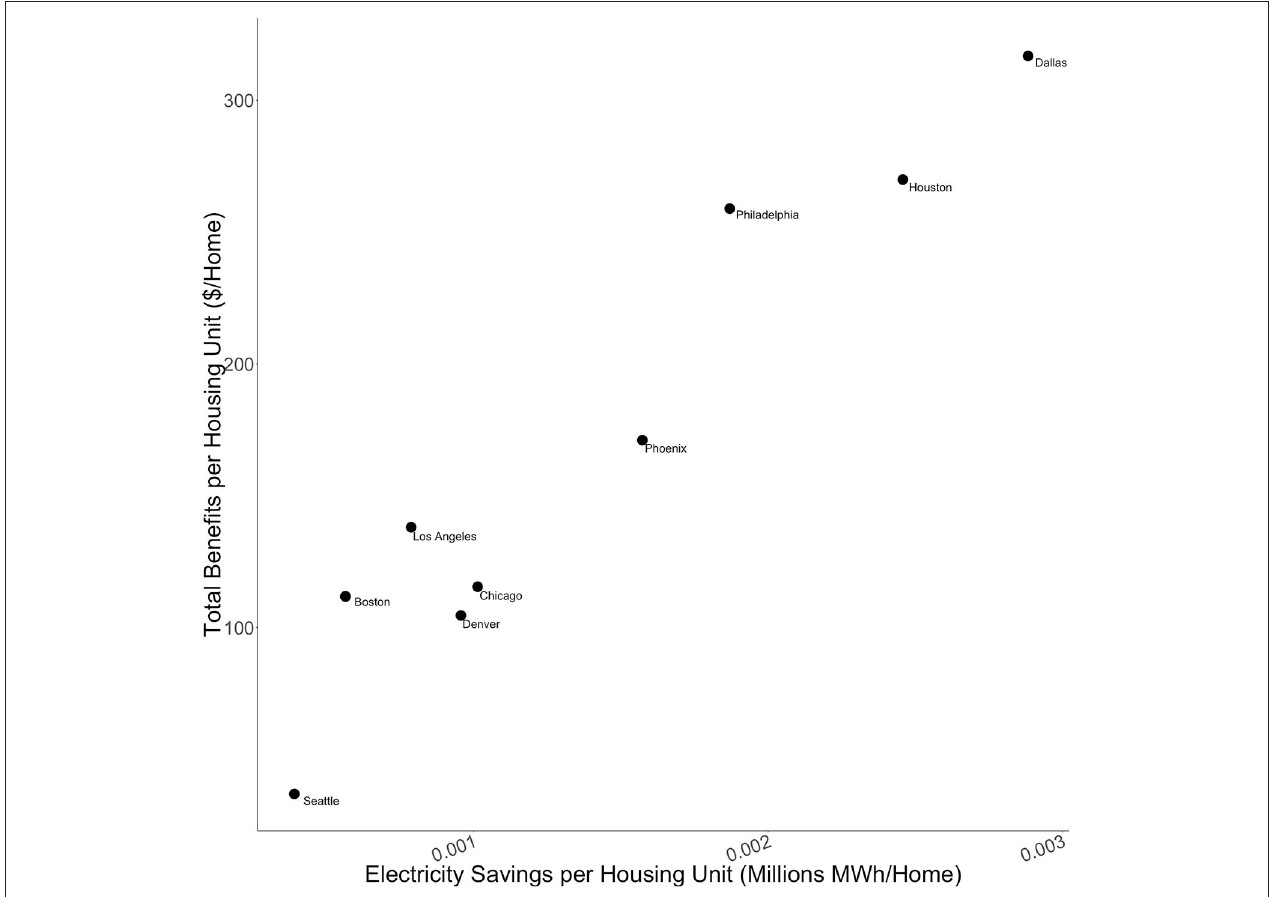
FIGURE 7 | Total electricity savings per single-family detached home (1990 to 2010) and total benefits per MWh of electricity reduced from heat adaptation retrofits 2010.